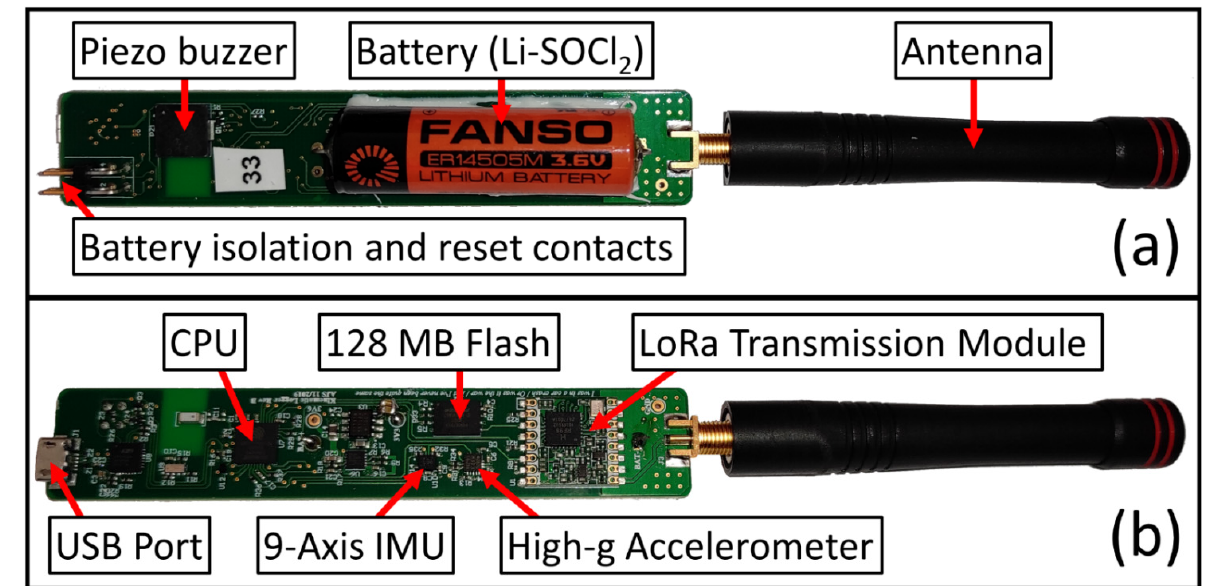
Figure 1. Kinematic Logger PCB, showing: ( a ) top side components, ( b ) bottom side components.